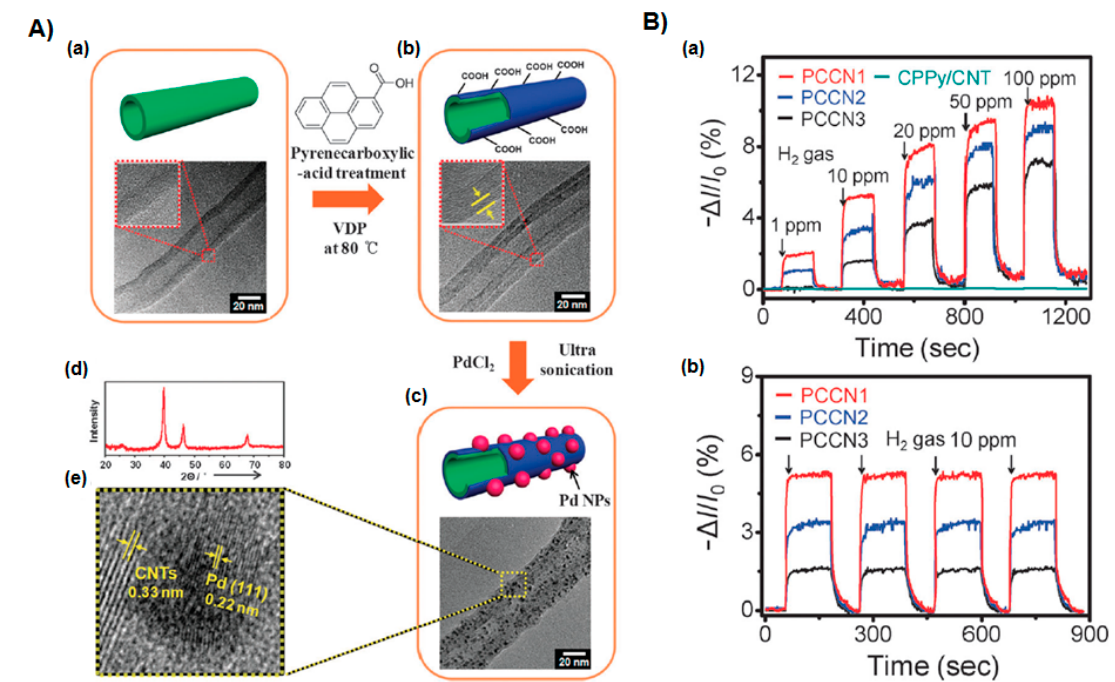
Figure 7. ( A ) Synthesis process of the PCCNs: ( a ) Bare CNT (inset indicates HR-TEM image of CNT of 30 nm in diameter); ( b ) ultrathin CPPy layer-wrapped CNT (inset indicates HR-TEM image of CPPy-CNTs with the skin thickness of 5 nm in diameter); ( c ) PCCNs; ( d ) XRD pattern; ( e ) HR-TEM of Pd nanoparticles. ( B ) Sensing performance of H 2 sensors based on the nanohybrids. Real-time responses of the nanohybrid sensors ( a ) upon cyclic exposure to H 2 (1 to 100 ppm, V ds = − 50 mV) and ( b ) on periodic exposure to 10 ppm H 2 ( Δ I / I 0 = ( I − I 0 )/ I 0 , where I 0 is the initial current, and I is the instantaneous current). Reprinted with permission from [61]. Copyright 2013, Royal Society of Chemistry.